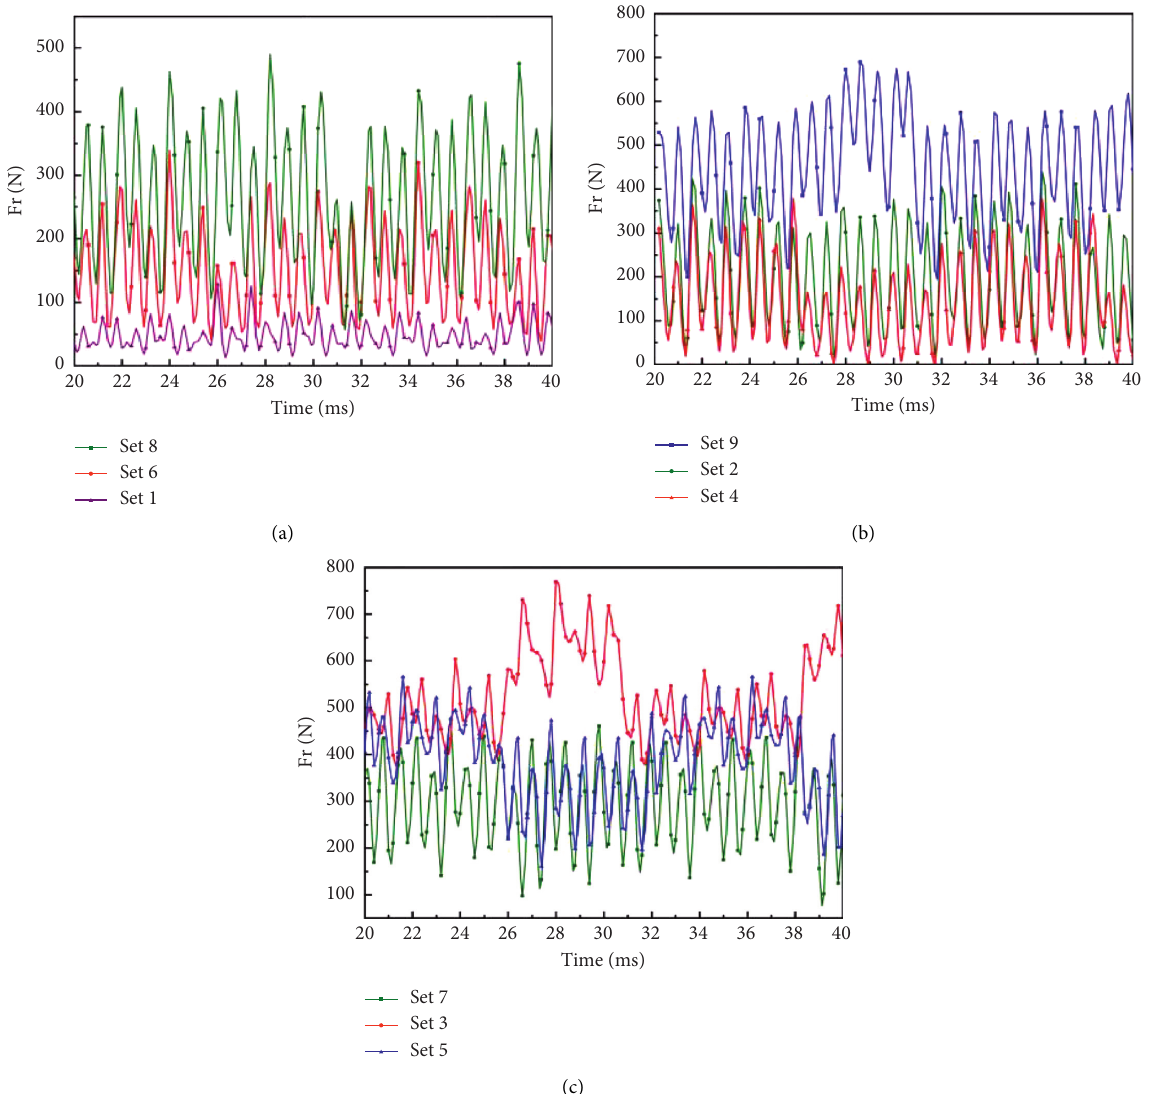
Figure 10: Radial EMF versus time for different φ , β sets. (a) θ � 7 . 5 ° . (b) θ � 15 ° . (c) θ � 22 . 5 °